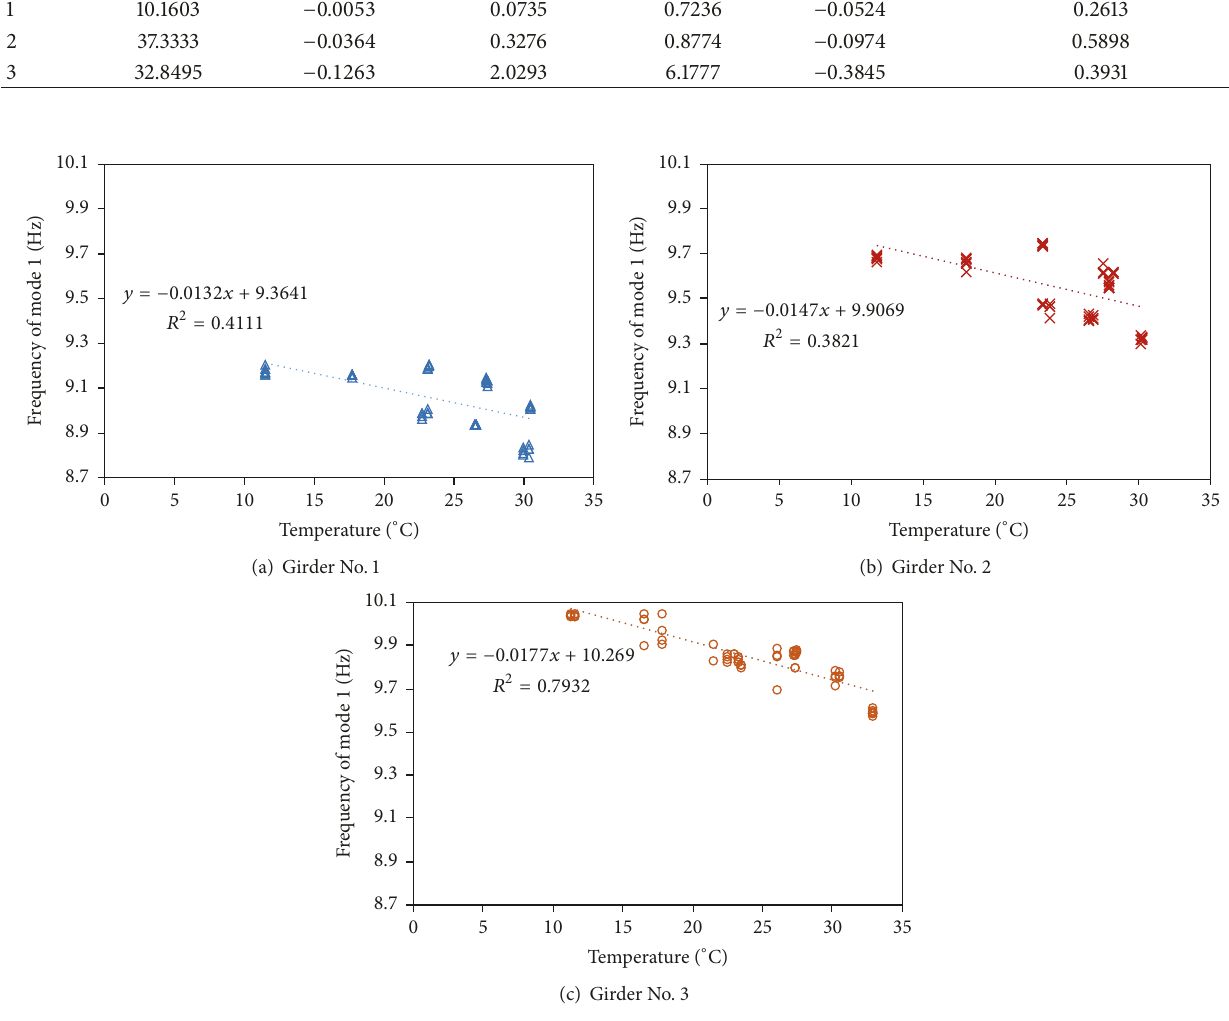
Figure 7: ((a)–(c)) Relation of frequencies of mode 1 to